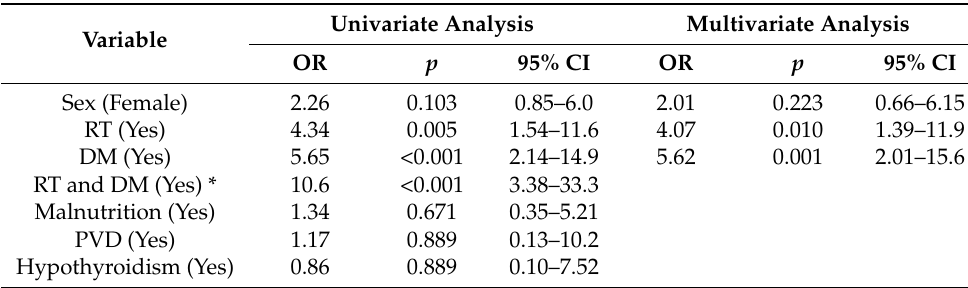
Table 2. Univariate and multivariate binary regression analysis to assess wound healing response in the presence of risk